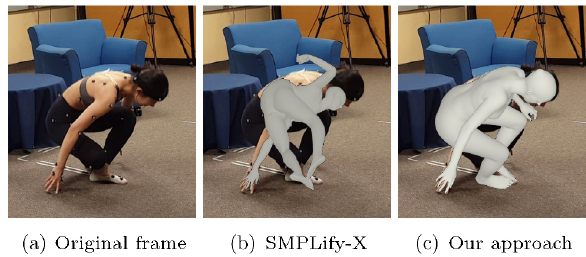
Fig. 10 Subject 45 from MoVi performing Complex Motion. SMPLify-X (b) is unable to capture the correct pose, but our method (c) estimates a nearly accurate body